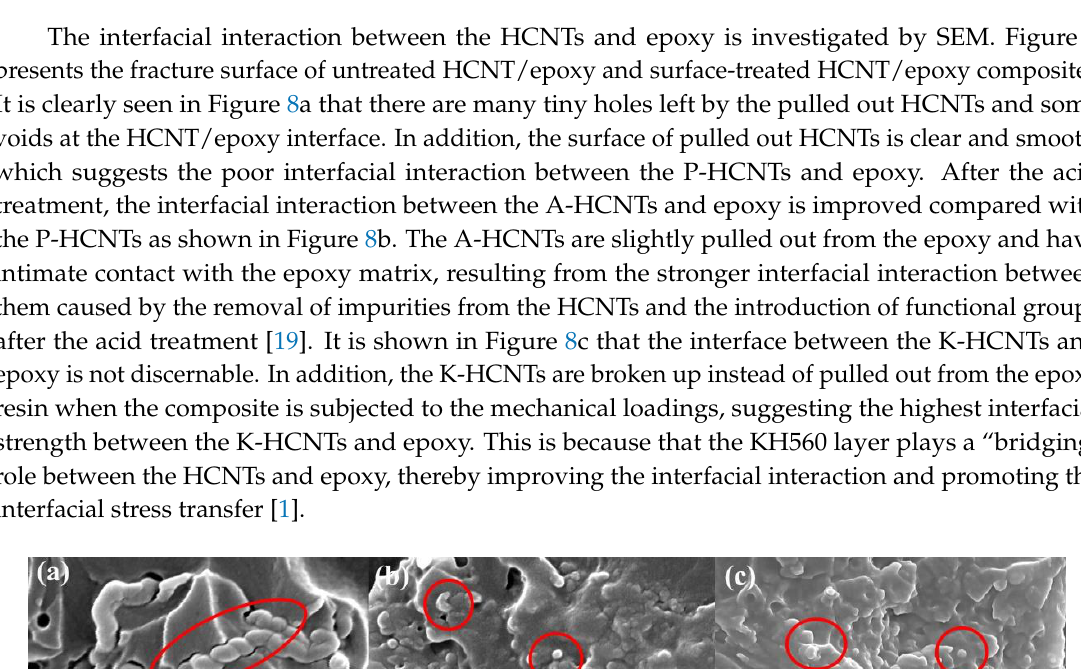
Figure 7. Optical microscopy images for the dispersion of P-HCNTs ( a ), A-HCNTs ( b ) and K-HCNTs ( c ) in uncured epoxy.